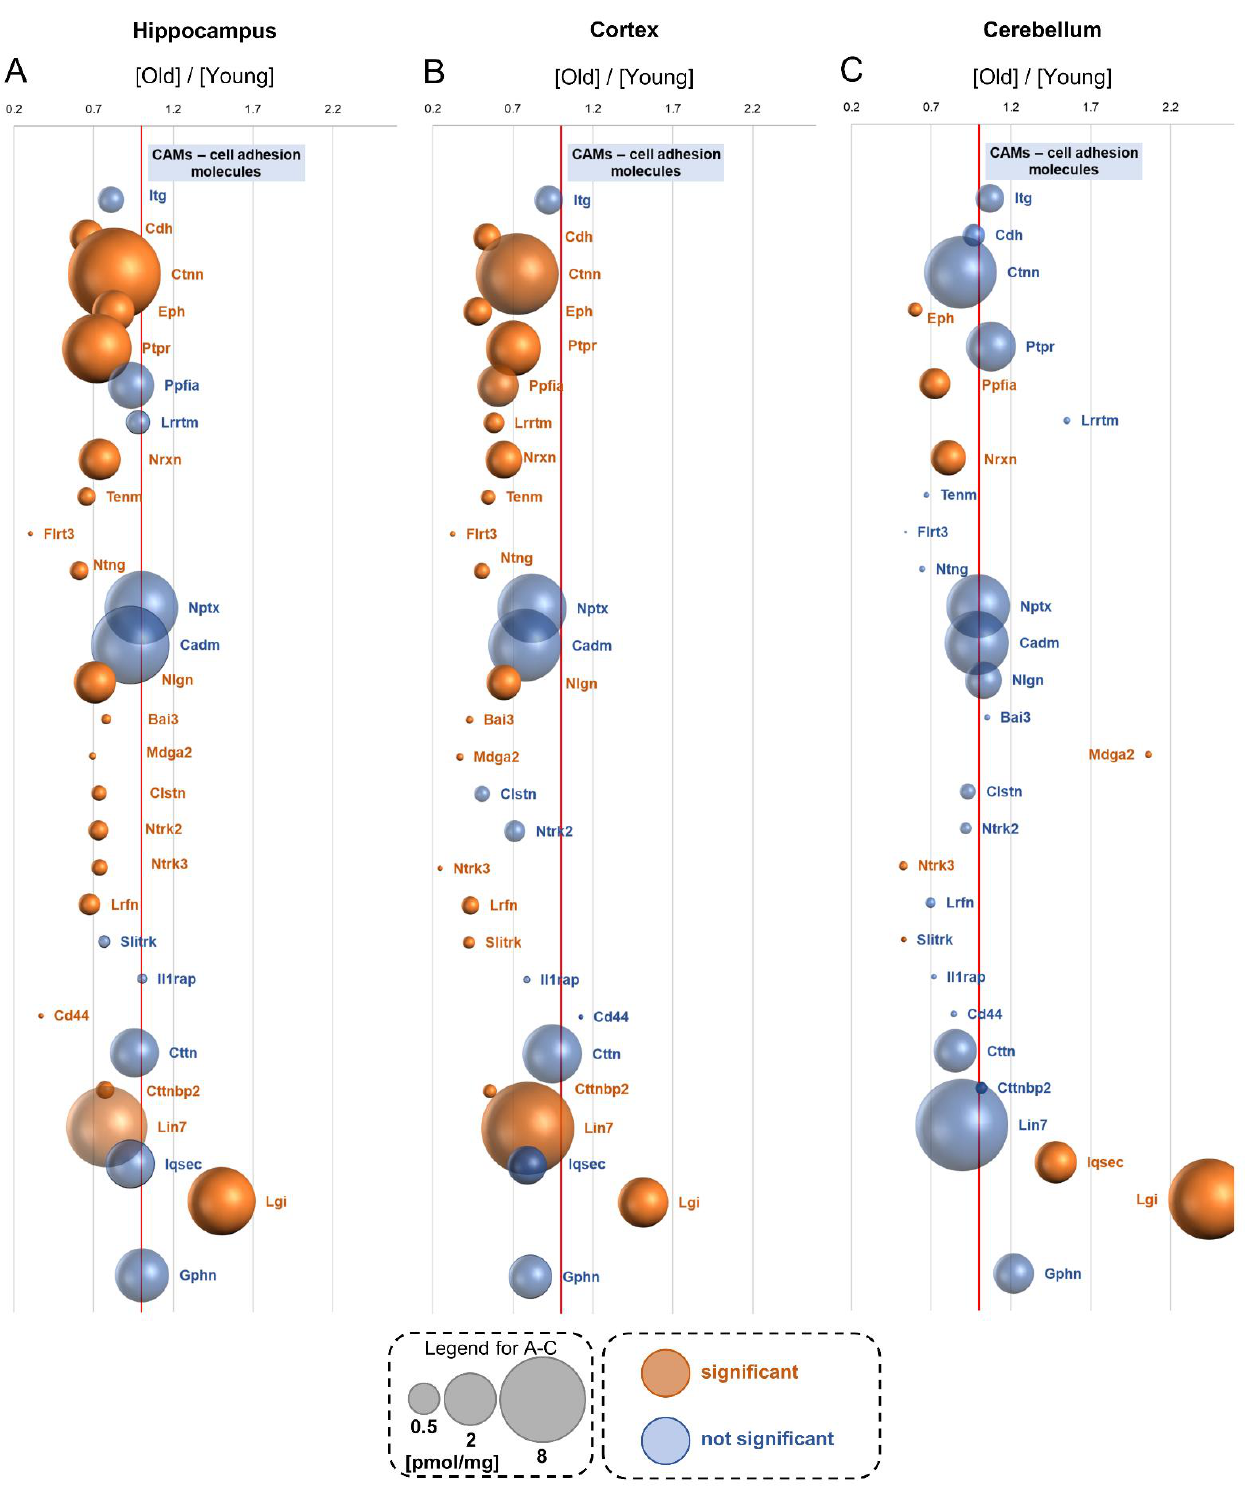
Figure 8. Changes in proteins of the trans-synaptic cell adhesion molecule group upon aging. Plot shows the ratios of the proteins in old vs. young brain formations in: hippocampus ( A ), cortex ( B ) and cerebellum ( C ). The size of bubbles is proportional to the average protein concentration in the respective old brain structures. Statistically significant differences are shown as the red bubbles.